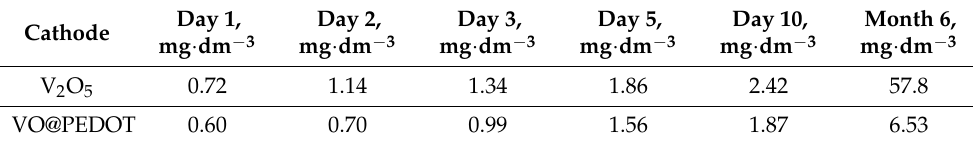
Table 1. Solubility results for V 2 O 5 and VO@PEDOT in 3 mol ∙ dm − 3 ZnSO 4 . Cathode